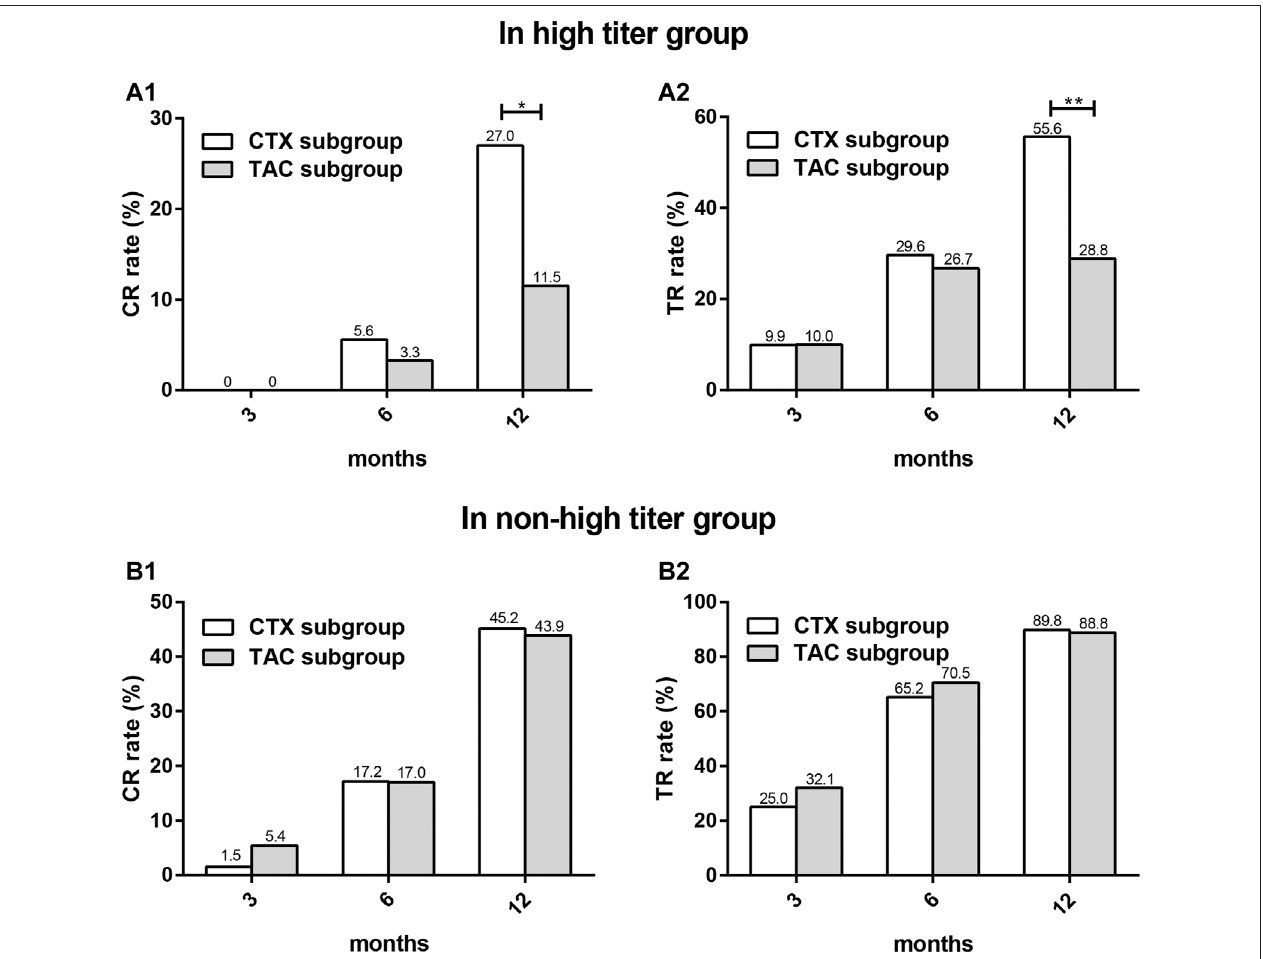
FIGURE5| ThecomparisonofCRandTRratesbetweenCTXsubgroupandTACsubgroupatdifferenttimepointsintwotitergroups.CR (A1) andTR (A2) inhigh titer group, CR (B1) and TR (B2) in non-high titer group.CR: complete remission; TR: total remission; CTX: cyclophosphamide; TAC: tacrolimus. * p < 0.05, ** p < 0.01.